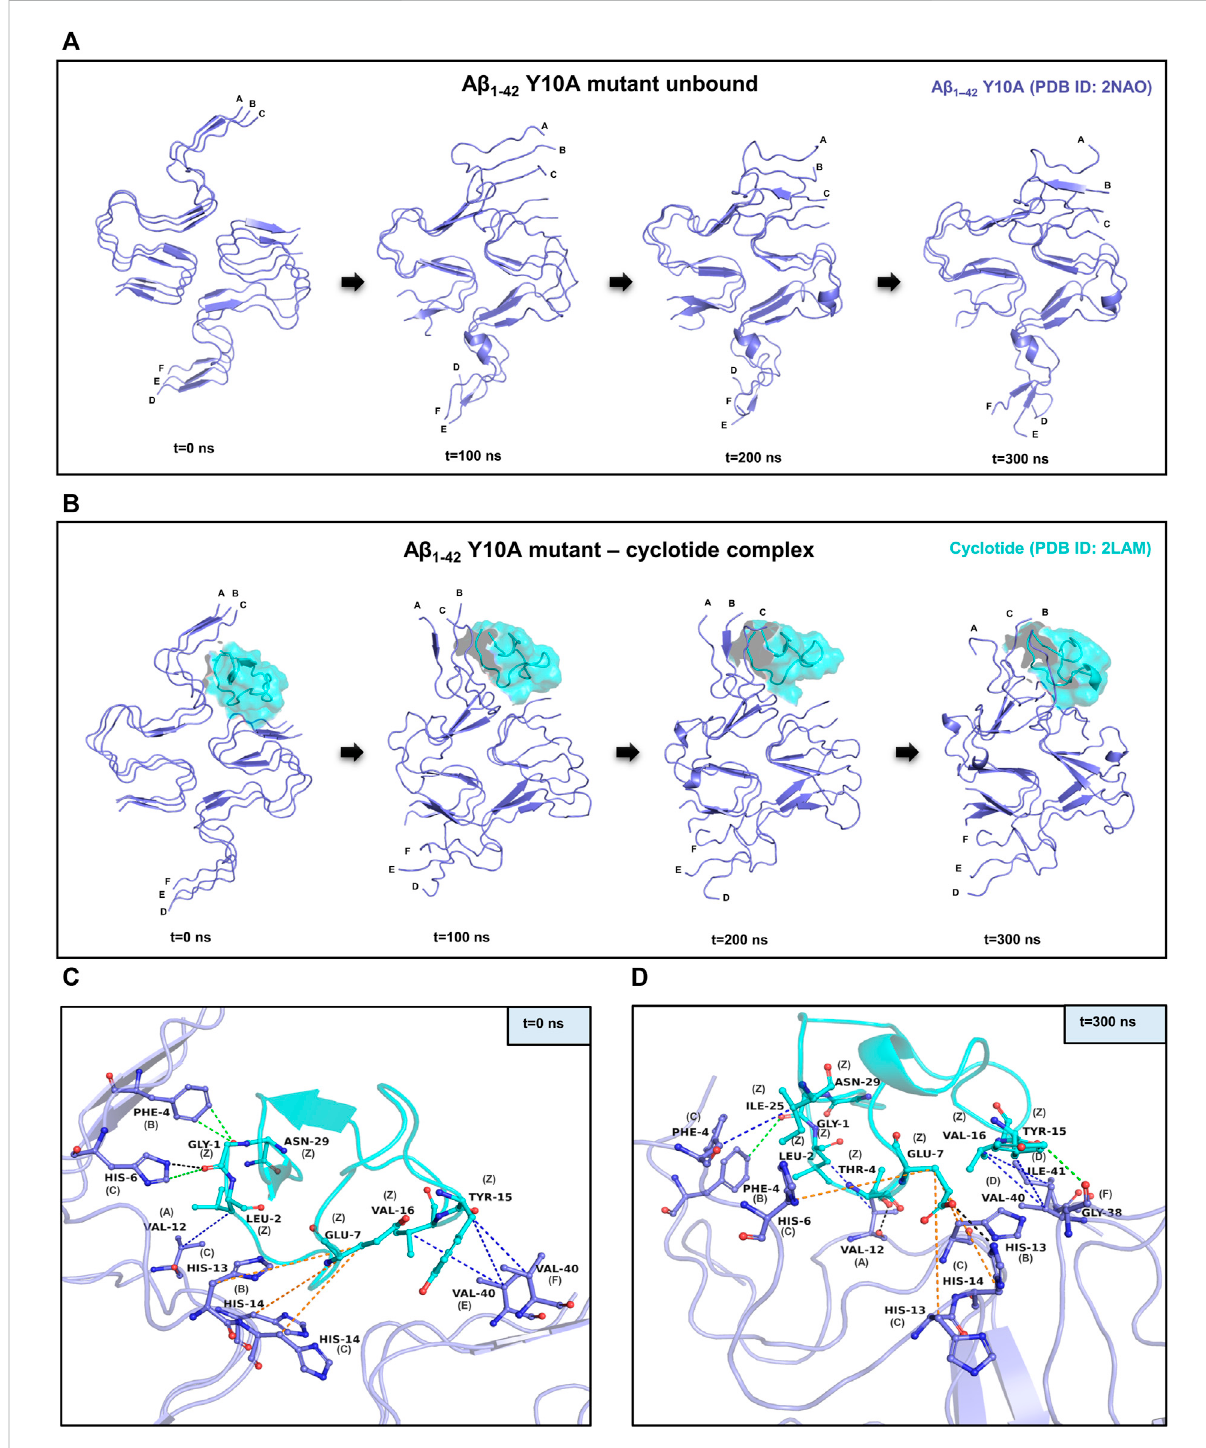
FIGURE 3 MD simulations between the Y10A mutant conformation of A β 1-42 and cyclotide Cter-M. (A) Snapshots of MD simulation of unbound Y10A mutant form of A β 1-42 (PDB ID: 2NAO; green coloured cartoon representation) at different time points along the simulation period. (B) Snapshots of MD simulation of Y10A mutant form of A β 1-42 (PDB ID: 2NAO; green coloured cartoon representation) and Cter-M (PDB ID: 2LAM; cyan surface representation) complex at different time points along thesimulation period. Capital letters, which denote thepolypeptidechains of 2NAO, are placed at the 1 st residue of each chain. (C,D) Molecular interactions between theY10A mutant A β 1-42 fi bril (PDB ID: 2NAO; chains A-F; green cartoon representation) and cyclotide Cter-M (PDB ID: 2LAM; chain Z; cyan cartoon representation) at the beginning (0 th ns snapshot) and end (300 th ns snapshot)ofthesimulationperiod,respectively.Colourschemeforinteractionsused:classicalhydrogenbondsinblack,aromatichydrogenbondsin green, hydrophobic interactions in blue and electrostatic interactions in